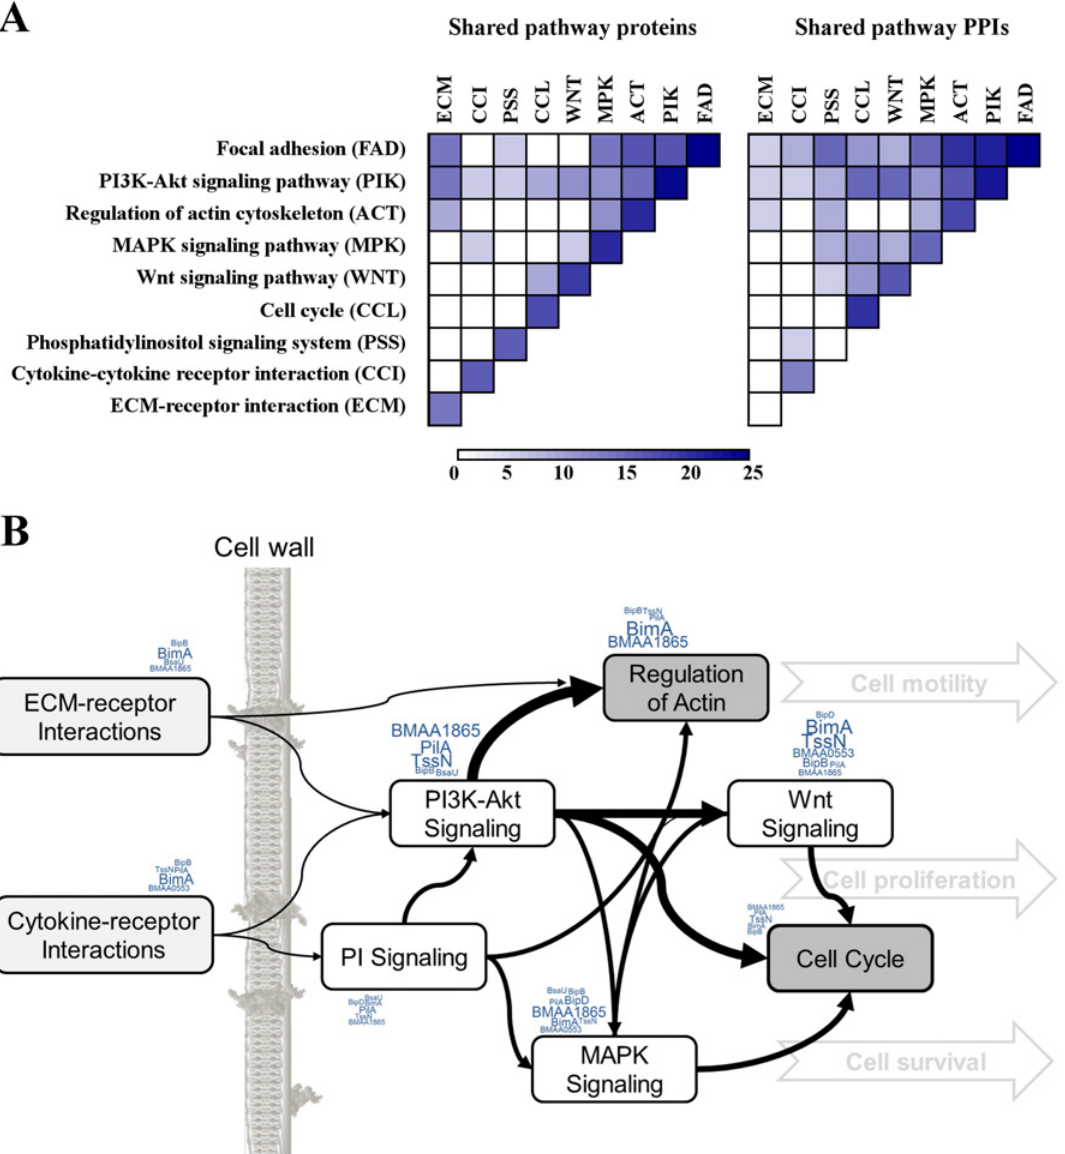
Fig 5. Crosstalk between host pathways targeted by B. mallei virulence factors. A) The number of shared proteins and shared pathway protein-protein interactions (PPIs) among human proteins interacting with B. mallei that appeared in the focal adhesion pathway and in up to eight other molecular pathways that shared proteins (partially overlapped) with this pathway. The number of shared proteins across pathways was smaller than the number of shared pathway PPIs. B) The location and number of crosstalk interactions affected by B. mallei centered around the focal adhesion pathway and appear as arrows with line thicknesses proportional to the number of shared PPIs. The identity and number of virulence factors that target each pathway are illustrated using a word cloud. By preferentially targeting signaling pathways, the effect of one protein modulated through interaction with a virulence factor could propagate and disproportionally influence a larger number of biological